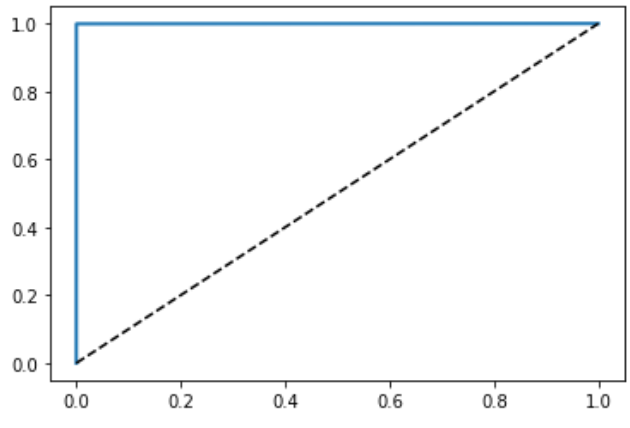
Figure 8. AOC of good classifiers.